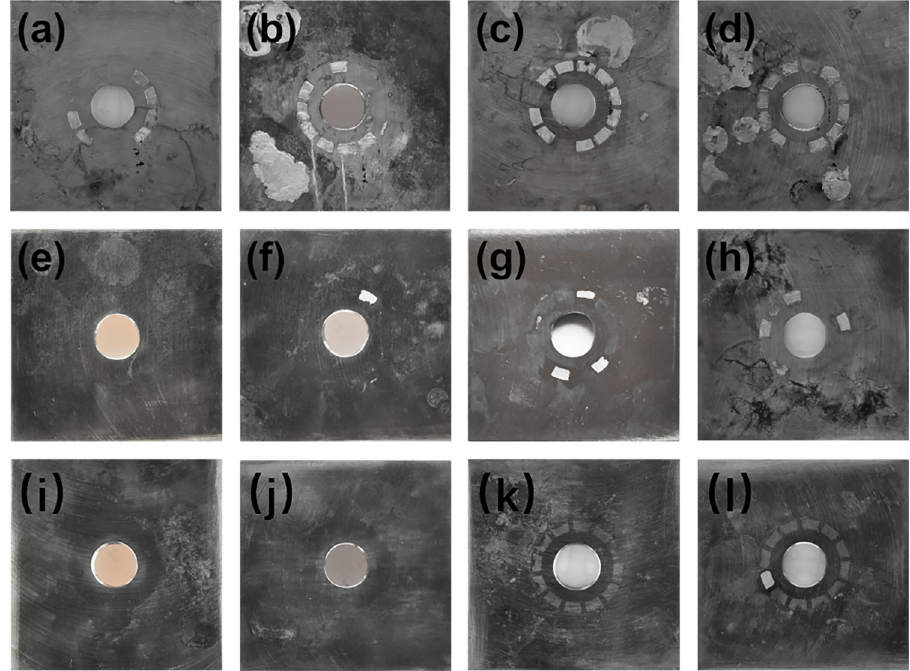
Fig. 2 Macroscopic corrosion morphologies of three stainless steels after removing biofoulings and corrosion products. a – d shows the surface of 316L SS for 6, 12, 24, 36 months. e – h shows the surface of 2205 DSS for 6, 12, 24, 36 months. i – l shows the surface of 2507 SDSS for 6, 12, 24, 36